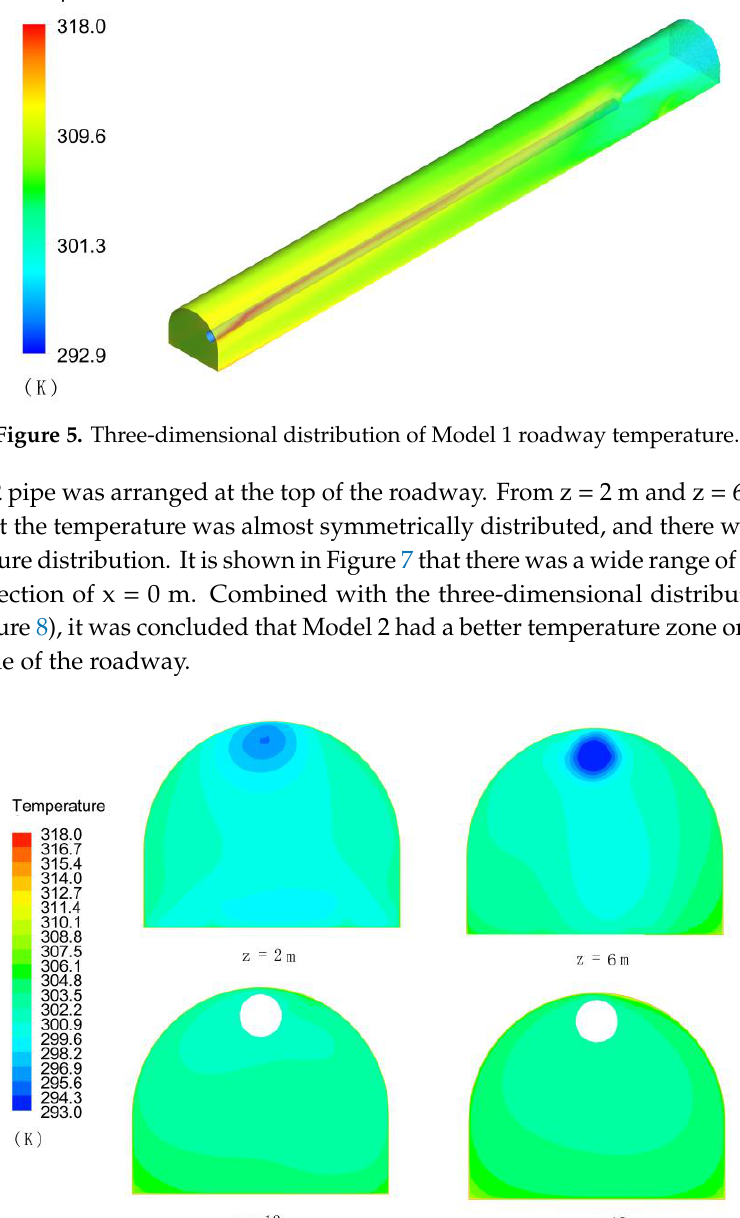
Figure 4. Model 1 side view (x = 0).